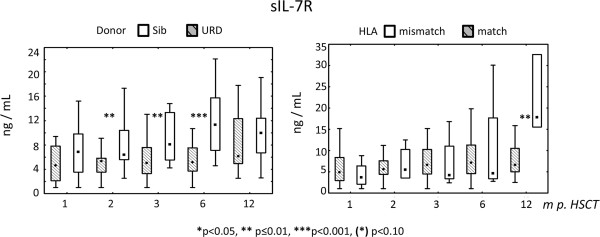
sIL-7R levels after HSCT and analysis of clinical endpoints, i.e. type of donor (HLA-identical sibling (sib) or unrelated donor [32] and HLA-match versus HLA-mismatch.